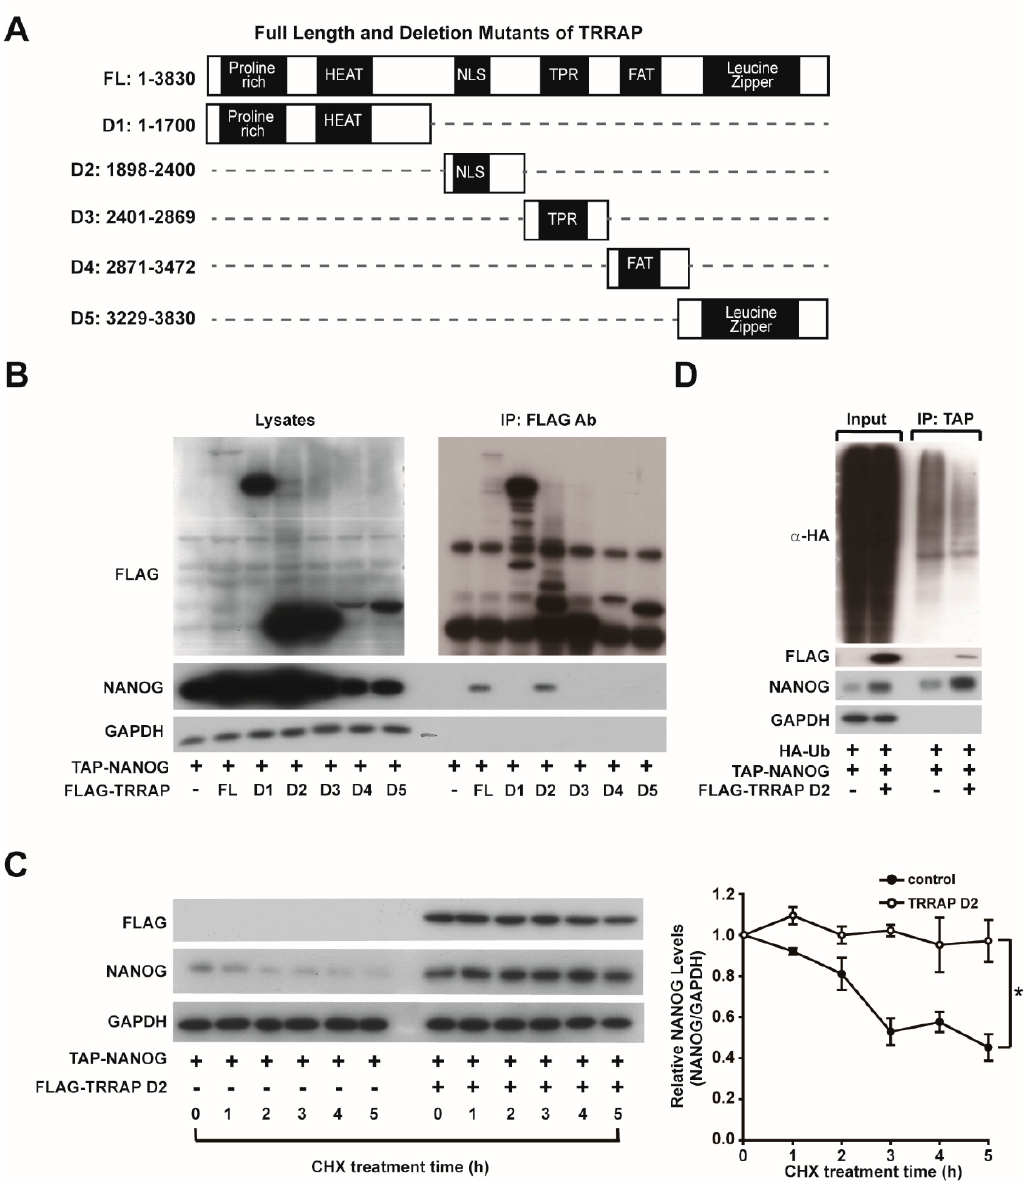
Figure 2. Identification of the TRRAP domain that regulates the ubiquitination of NANOG. ( A ) Schematic illustration of full-length and fragments of FLAG-tagged TRRAP. ( B ) Co-immunoprecipitation of FLAG-tagged TRRAP constructs and NANOG in HEK293 cells. HEK293